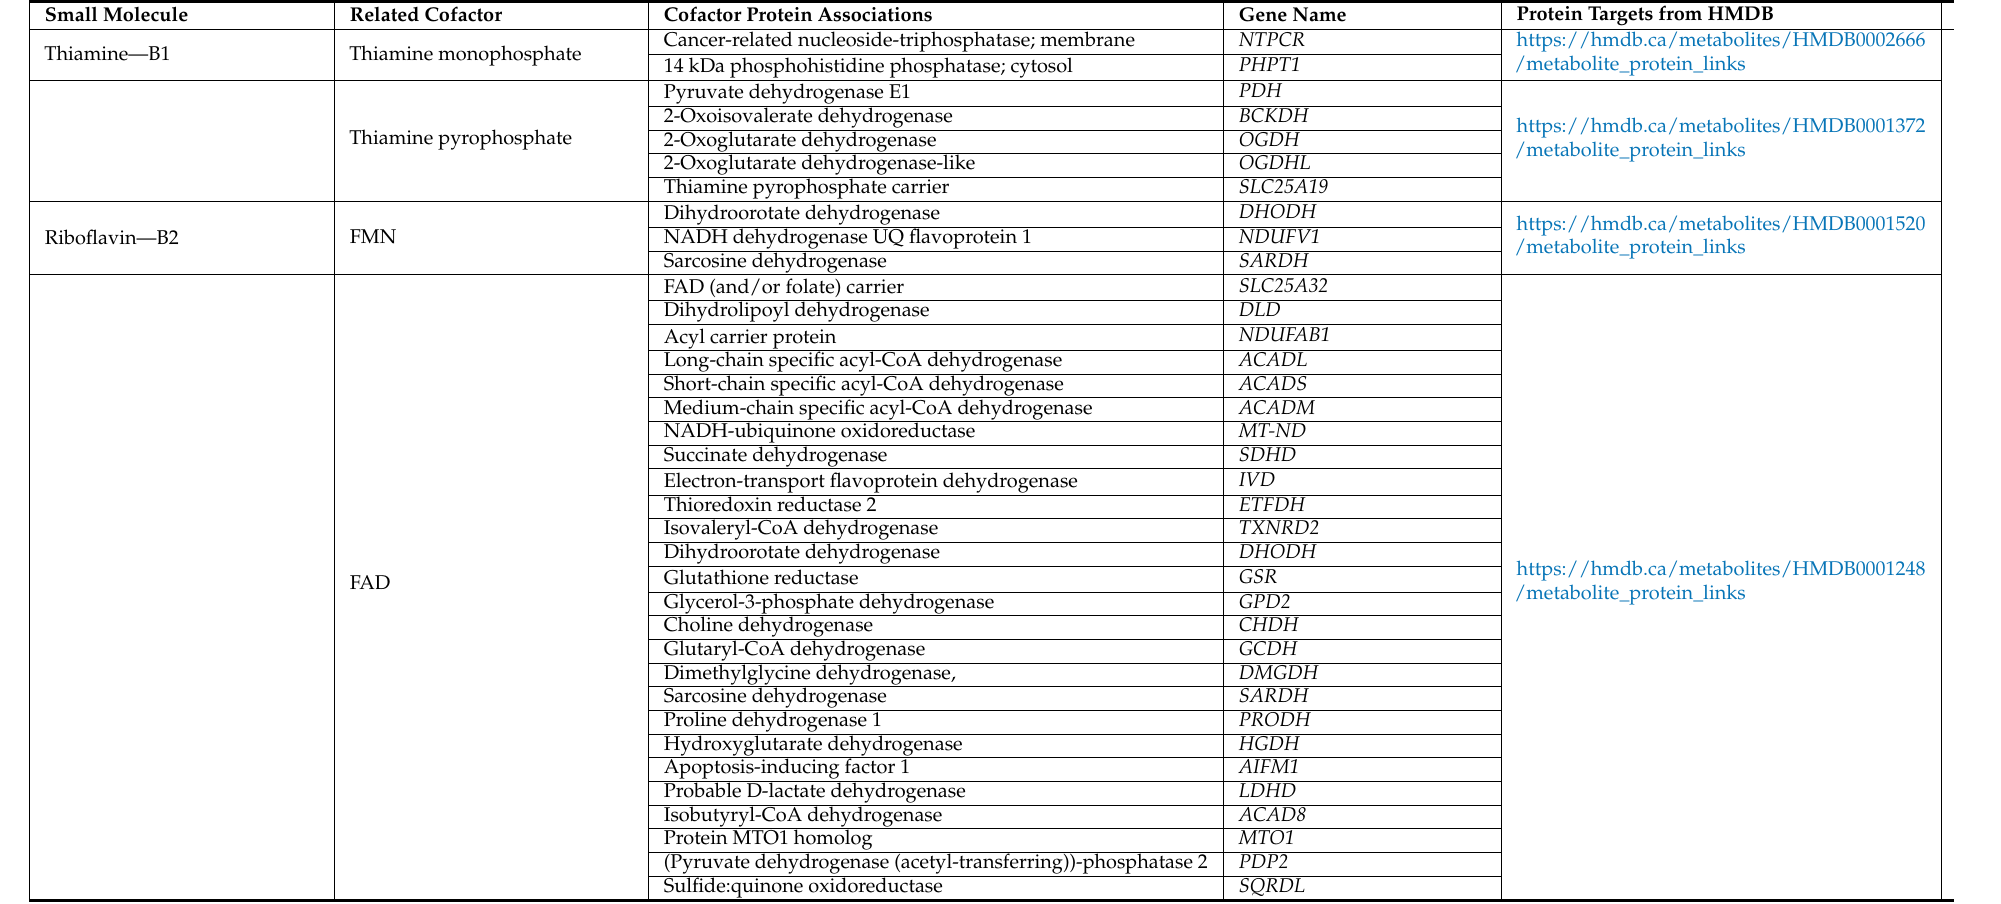
Table 3. List of the main mitochondrial/cytosolic proteins involved in interactions with the reported hydrophilic vitamin-related cofactors. All the indicated web-links were accessed on 8 April 2022 for a final